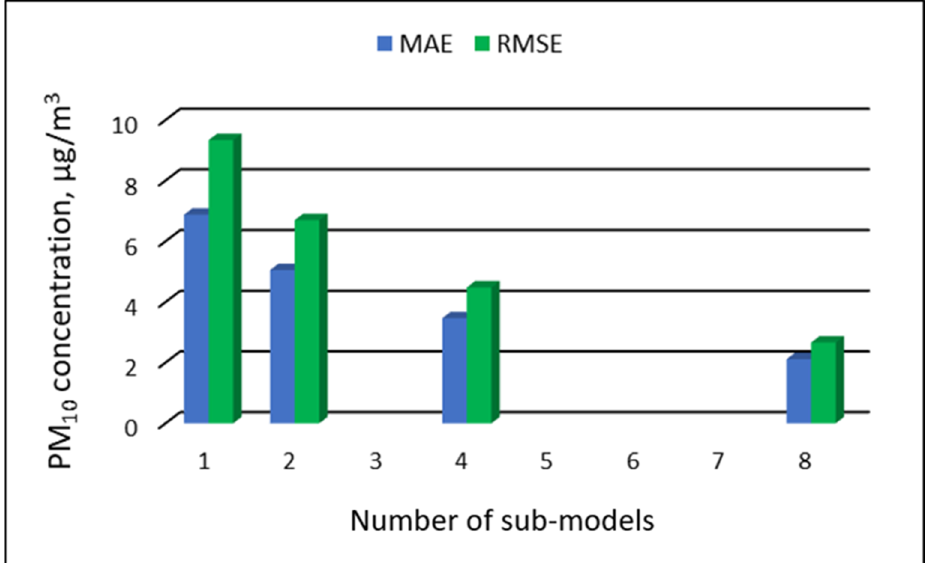
Figure 24. Overall MAE and RMSE values for PM 10 concentration prediction in RVS models depend- ing on the number of created sub-models, Z ł oty